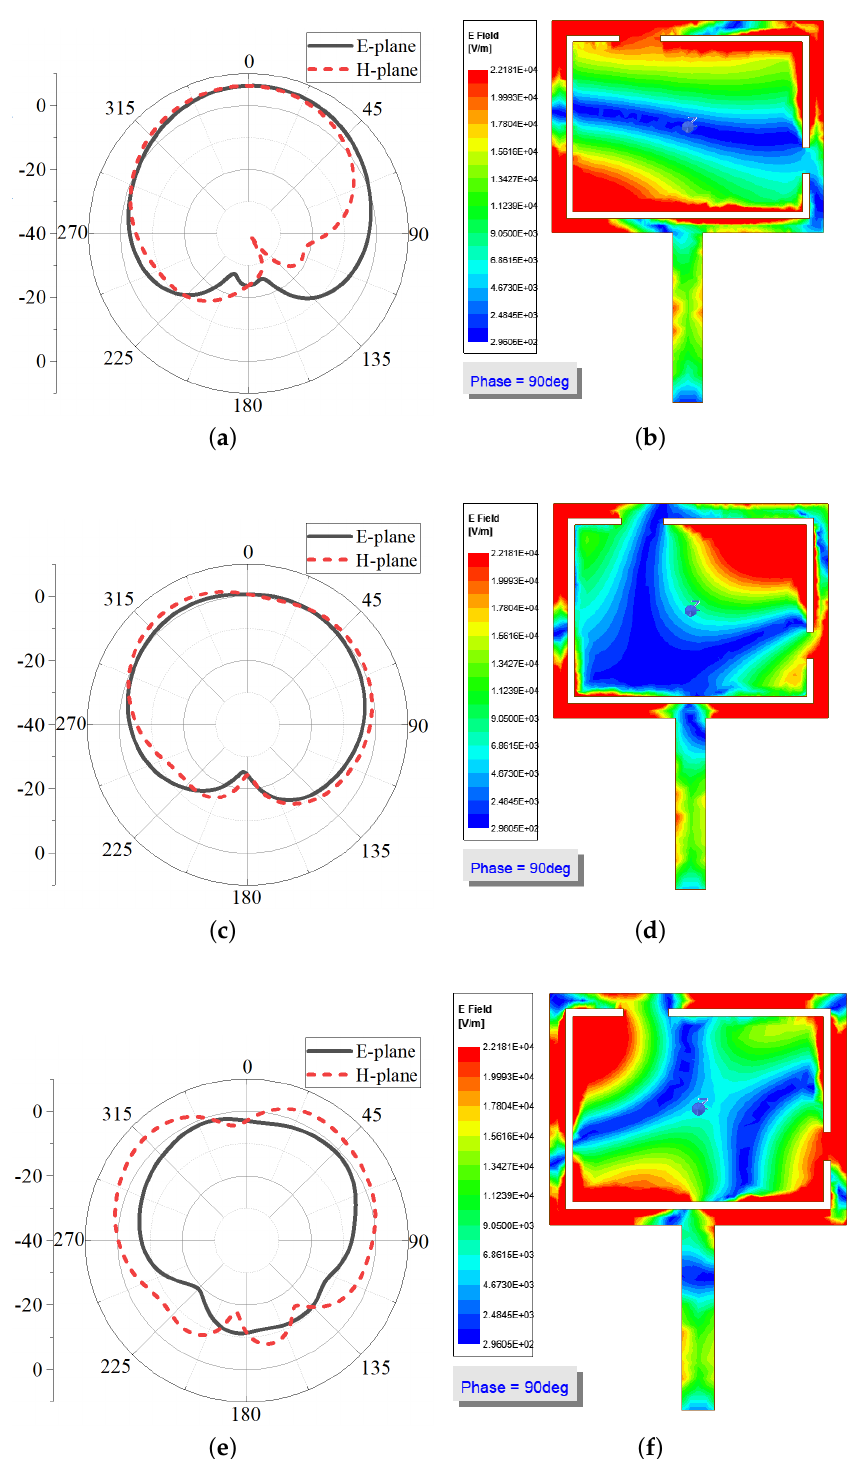
Figure 10. Simulated antenna performance at three bands. ( a ) Simulated radiation pattern at 5.8 GHz; ( b ) Surface current distribution at 5.8 GHz; ( c ) Simulated radiation pattern at 6.2 GHz; ( d ) Surface current distribution at 6.2 GHz; ( e ) Simulated radiation pattern at 8.4 GHz; and ( f ) Surface current distribution at 8.4